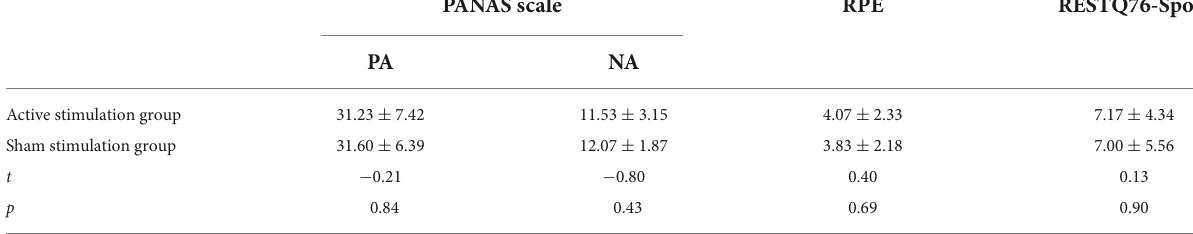
TABLE 2 Baseline data analysis of subjective report test of two groups of